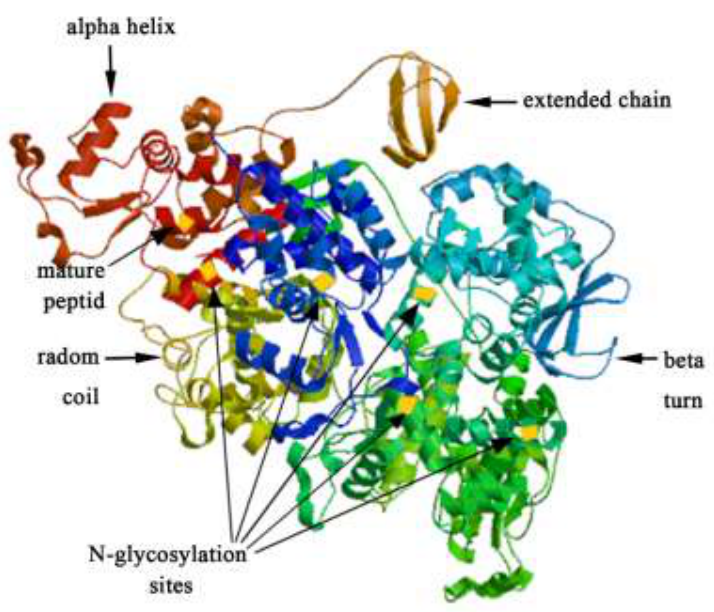
Figure 4. Prediction of proteintertiary structure.